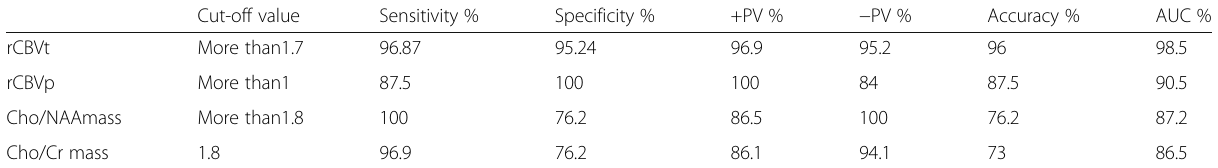
Table 3 Cut-off value, sensitivity, specificity, +PV, − PV, accuracy, and AUC of ADC values, rCBV ratios, and spectroscopic data for high- and low-grade gliomas Cut-off value